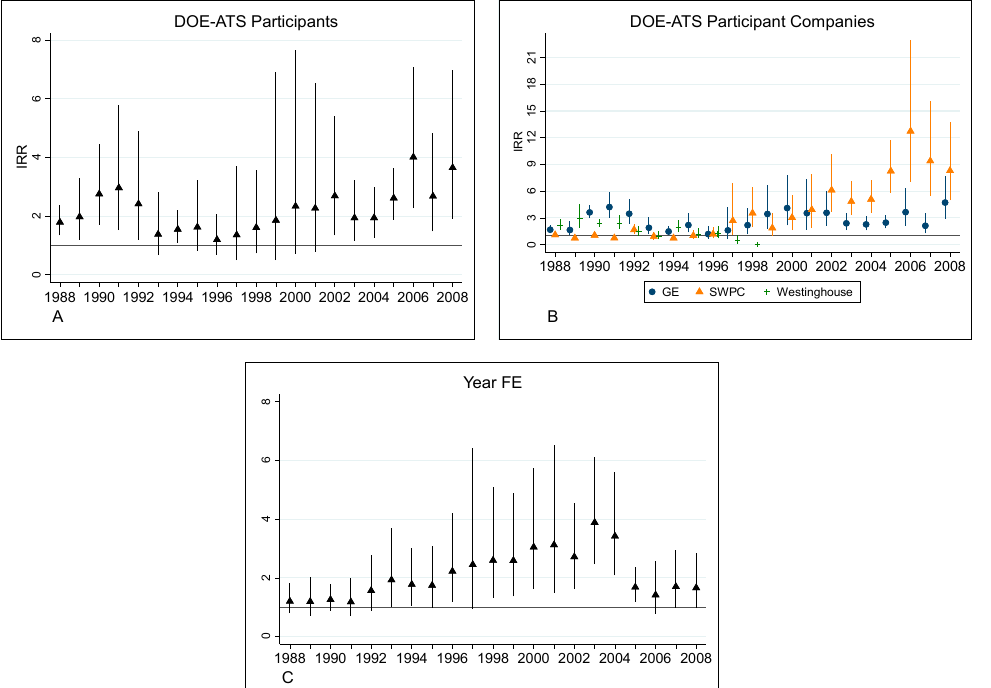
Figure 5. The coe ffi cient results from the models on patent counts with 95% confidence intervals, Figure 5. The coefficient results from the models on patent counts with 95% confidence intervals, represented as incidence-rate ratios. ( A ) is the joint treatment e ff ect for the program participants, represented as incidence-rate ratios. ( A ) is the joint treatment effect for the program participants, while ( B ) while ( B ) represents coe ffi cients for participant companies separately. ( C ) is the year fixed-e ff ects represents coefficients for participant companies separately. ( C ) is the year fixed-effects indicating overall patterns in ATS patenting by all companies during these years. indicating overall patterns in ATS patenting by all companies during these